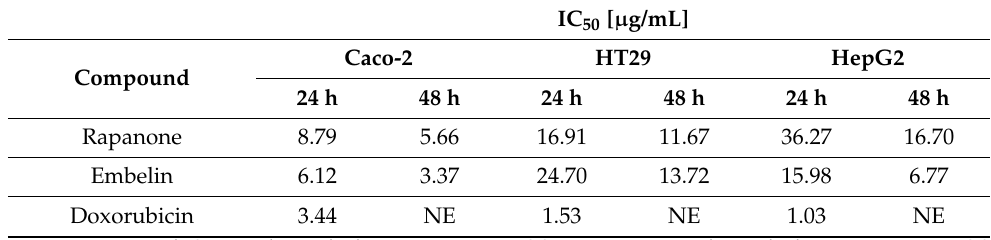
Table 4. IC 50 values of rapanone, embelin, and doxorubicin in colorectal carcinoma panel.